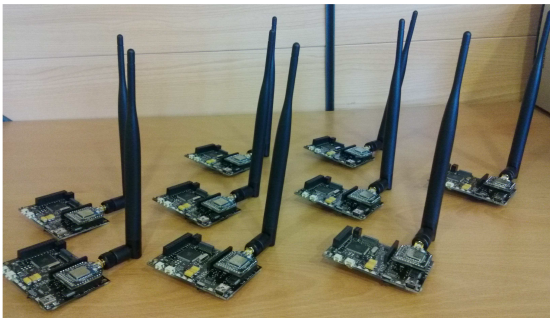
Figure 7. Waspmote devices equipped with BLE module.